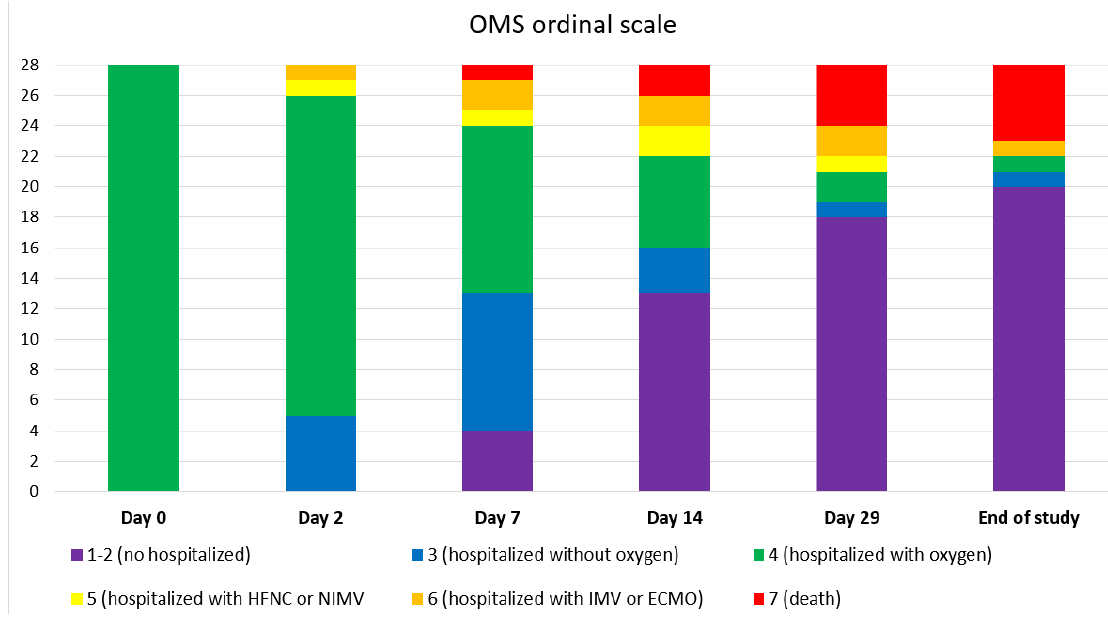
Figure 1. Clinical status according to OMS ordinal scale of COVID-19 severity at different days after sotrovimab infusion. Day 0 equals the day of sotrovimab infusion. A PaFi greater than 210 at infusion was associated with a lower rate of respiratory progression: 11.5% (3/26) versus 66.7% (4/6), p = 0.005 (Figure 2). Those receiving sotrovimab within the first 14 days from symptom onset had a lower progression risk: 12.0% ( n = 3/25) vs. 57.1% ( n = 4/7), p = 0.029 (Figure 2).